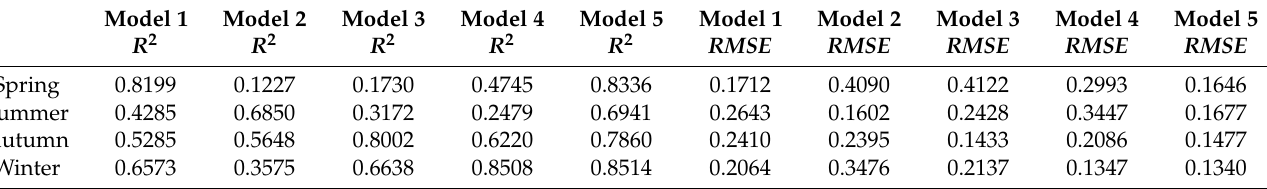
Figure 10. Seasonal comparisons between DNN-estimated AHI AOD and AERONET AOD for Models 1~5 (top to bottom rows). Left to right columns are corresponding to spring, summer, autumn and winter, respectively. Table 3. R 2 and RMSE list of seasonal comparisons shown in Figure 10.